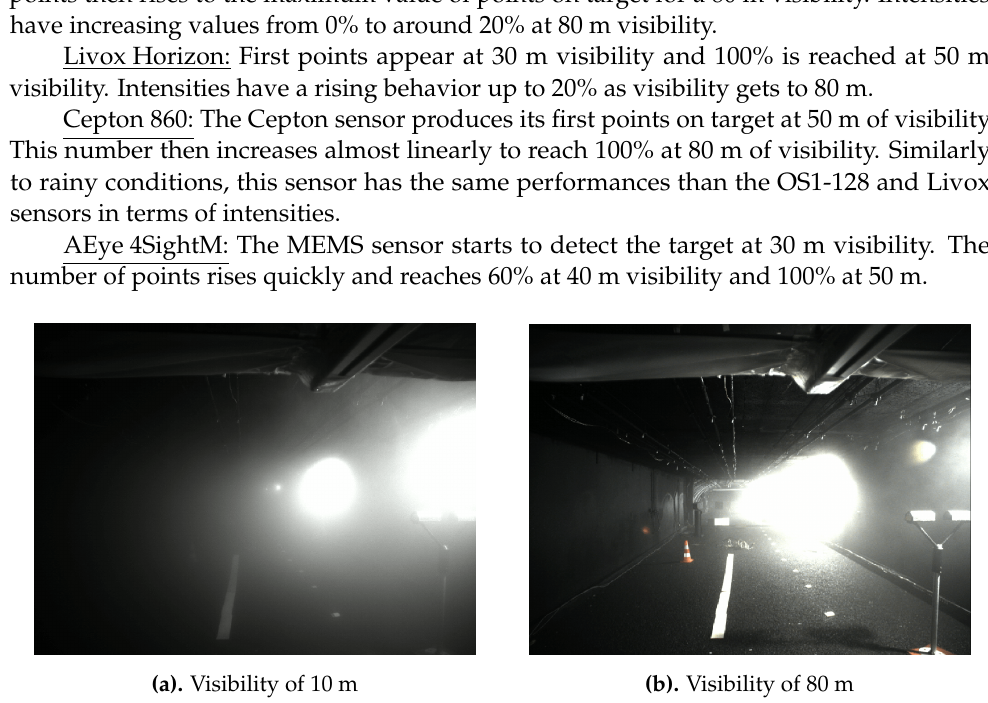
Figure 14. Screenshots taken from fog